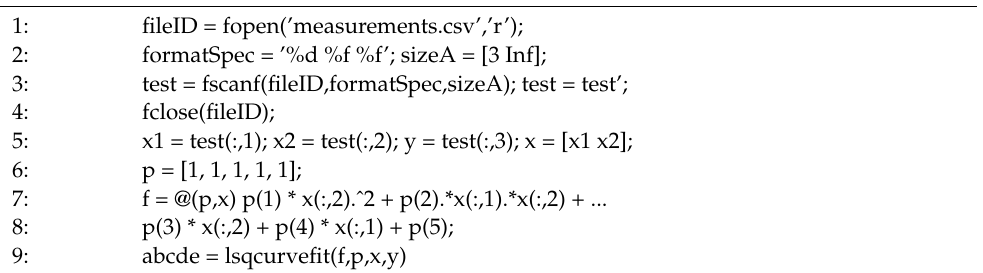
Algorithm 1 A Matlab program for computing coefficients of the Equation (5).